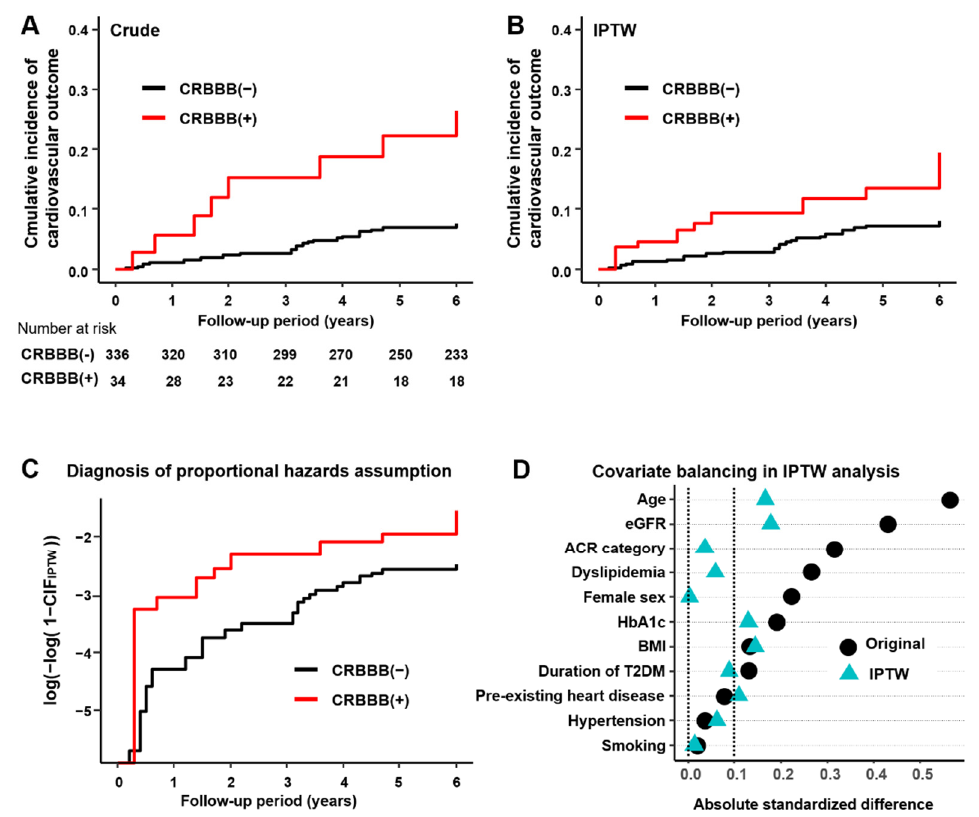
Figure 2. Association of CRBBB with cardiovascular events. ( A ) Crude cumulative incidence of the composite cardiovascular outcome with noncardiovascular death as a competing risk. ( B ) Cumulative incidence of the composite cardiovascular outcome with noncardiovascular death as a competing risk estimated by IPTW method. ( C ) Log of negative log(1 − CIF) plot for the diagnosis of proportional hazards assumption of cumulative incidence estimated by IPTW method. ( D ) Assessment of covariate balancing in analysis by IPTW method. Abbreviations: CIF, cumulative incidence function; CRBBB, complete right bundle branch block. Table 2. Unadjusted and adjusted association of CRBBB with cardiovascular events in